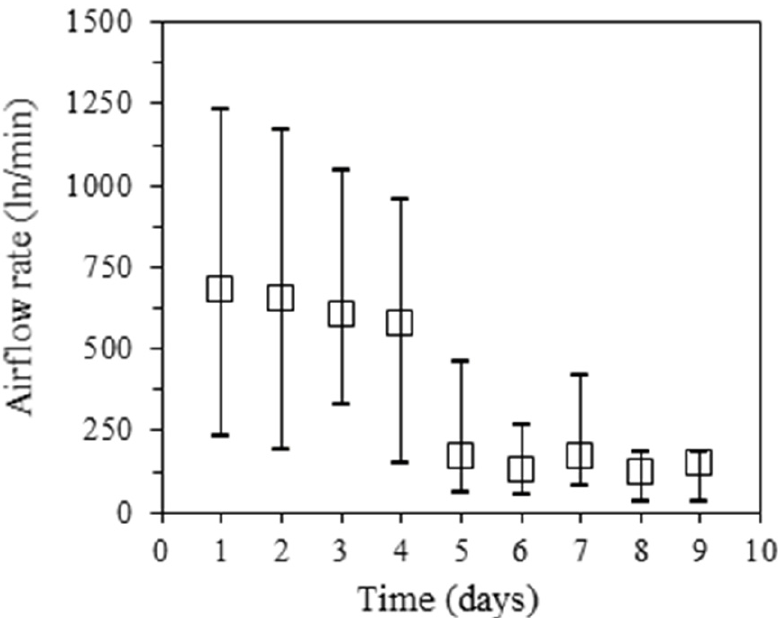
Figure 5. Daily average, maximum, and minimum airflow rates through the air inlets at the kiln door, including the results for both Tests 1 and 2.